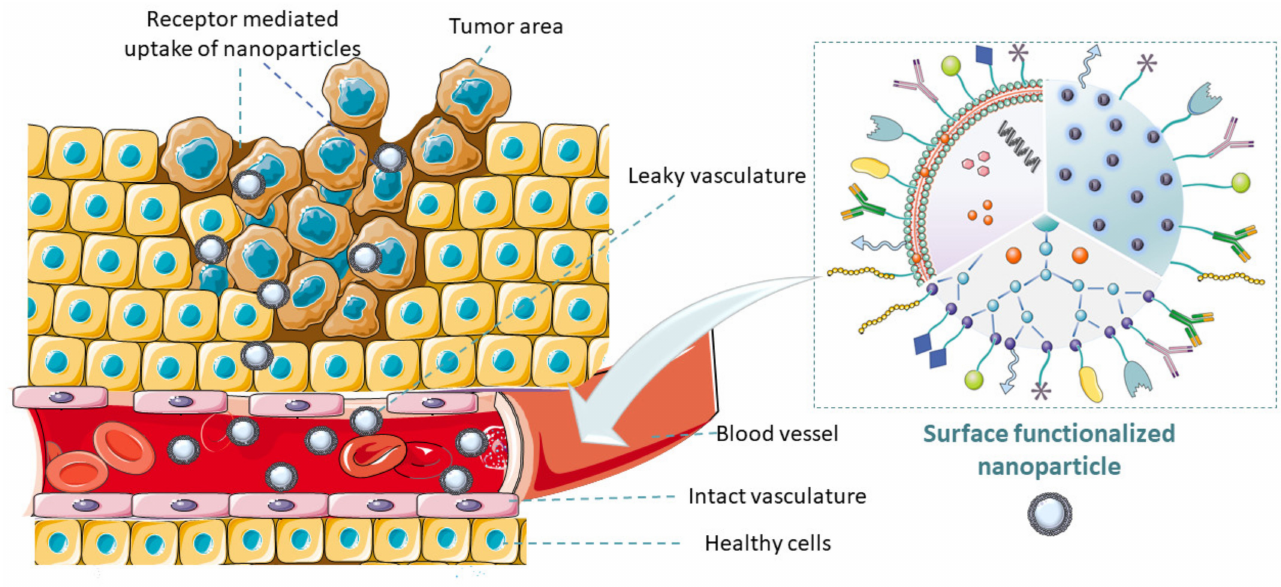
Figure 1. Graphical representation of the abstract. Illustration of tumor microenvironment and how surface-functionalized nanocarriers containing antitumor drugs actively target tumor